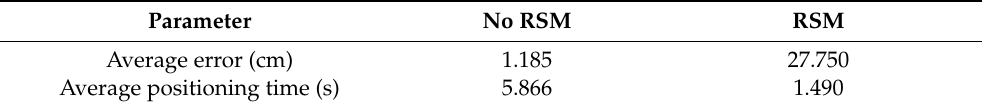
Table 12. Total average error and positioning time of using and not using RSM.